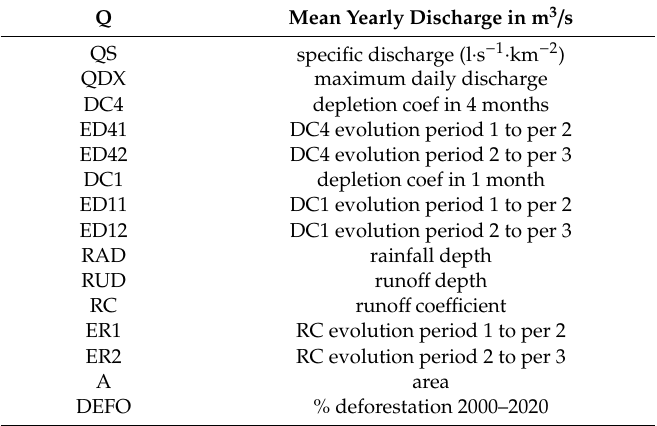
Table 4. List of the variables considered in the PCA analysis.